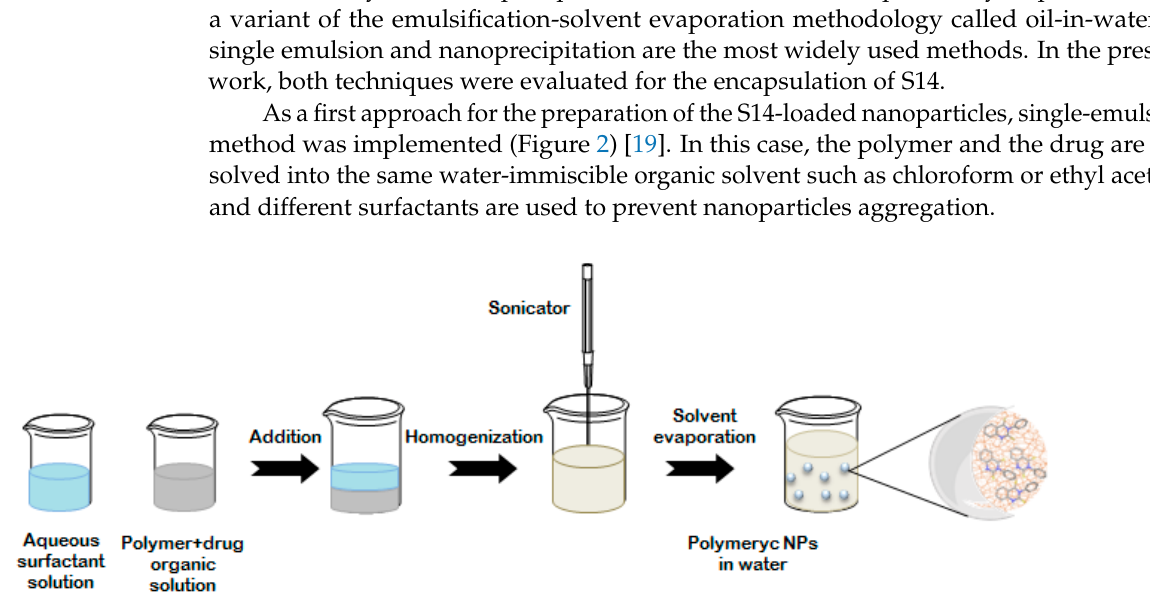
Figure 2. Schematic representation of the single-emulsion methodology for PLGA nanoparticles preparation. PLGA: poly(lactic-co-glycolic acid); NPs: nanoparticles.